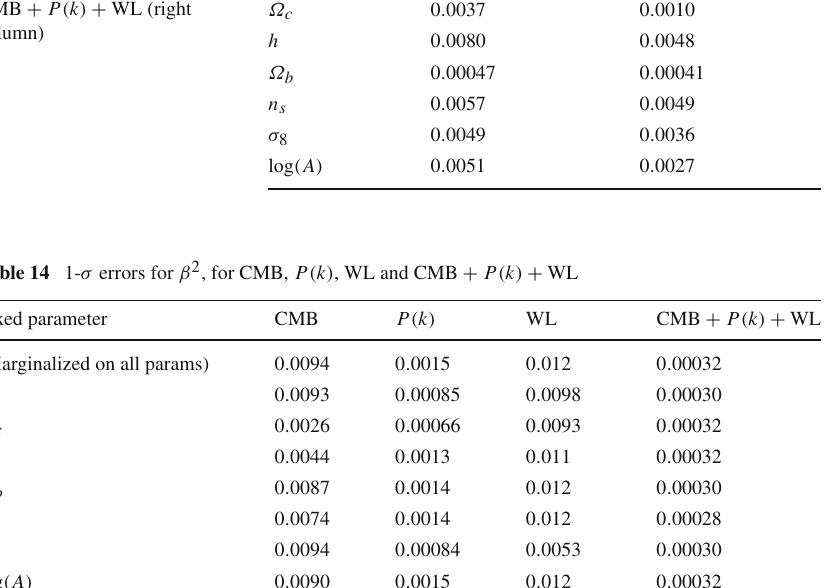
Table 13 1- σ errors for the set Θ ≡ { β 2 ,α,Ω c , h ,Ω n s σ 8 , log ( A ) } of cosmological parameters, combining